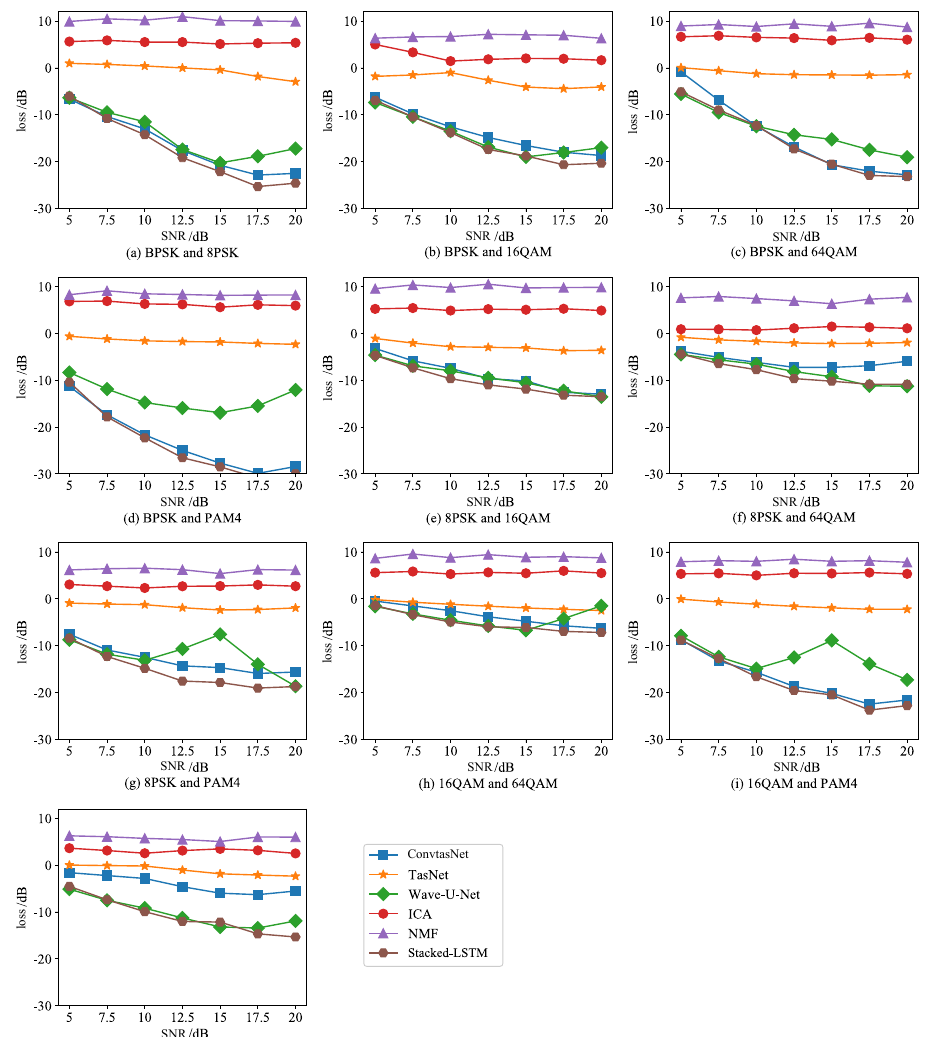
Figure 7. Loss under different